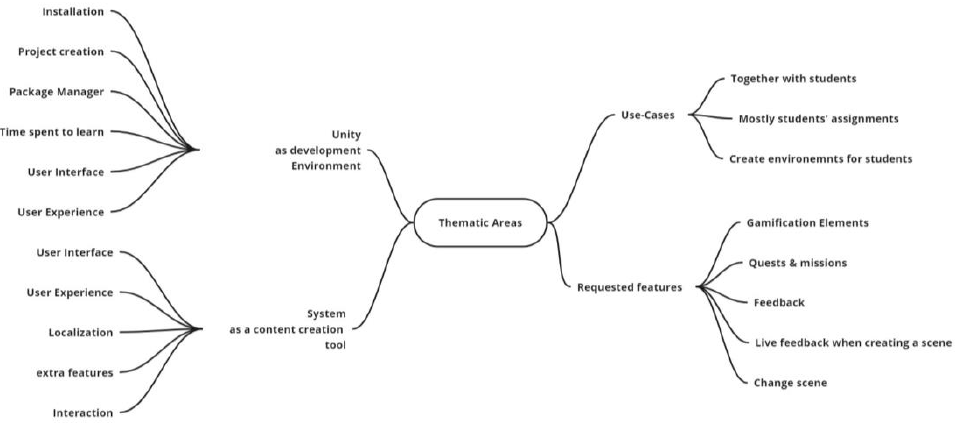
Figure 10. Mind map of the thematic areas retrieved from